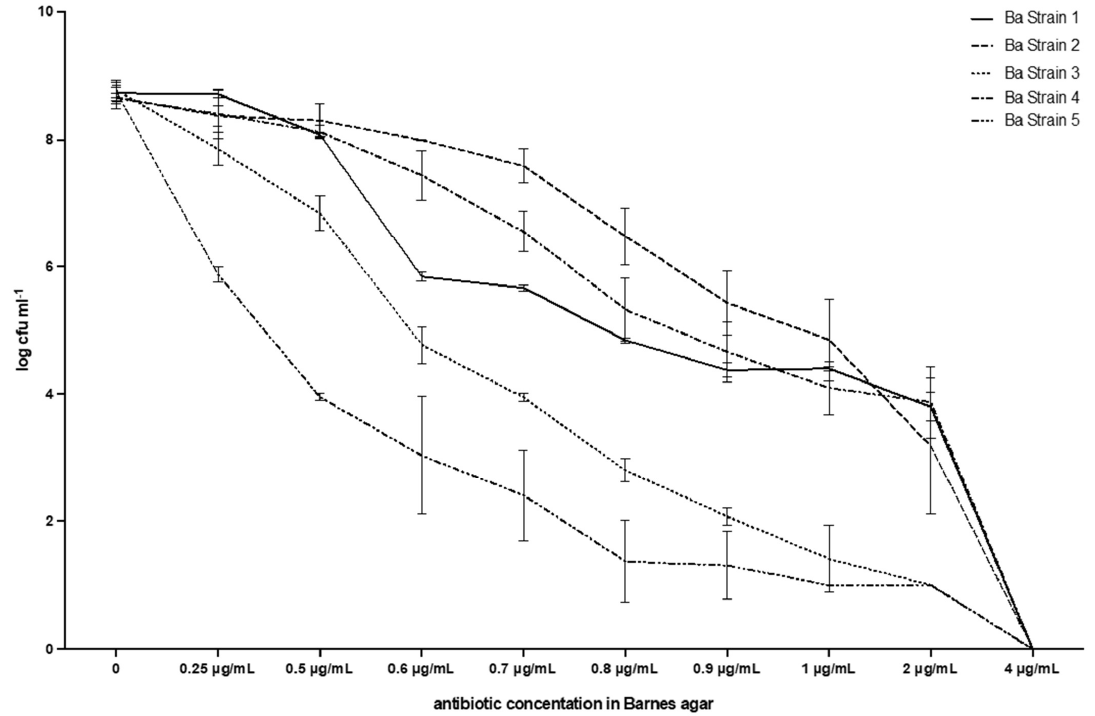
Figure 4. Breakpoint and evolution of the five strains of E. casseliflavus tested with the method de- scribed in this work. Barnes